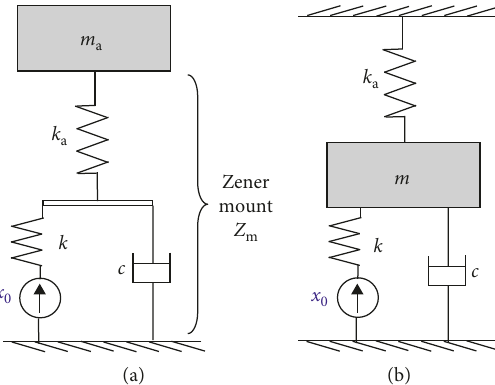
Figure 3: One-body LESs representing the first (a) and the second (b) mode of the two-body LES in Figure 1(b). The system in (a) is specifically called a Zener mount system.